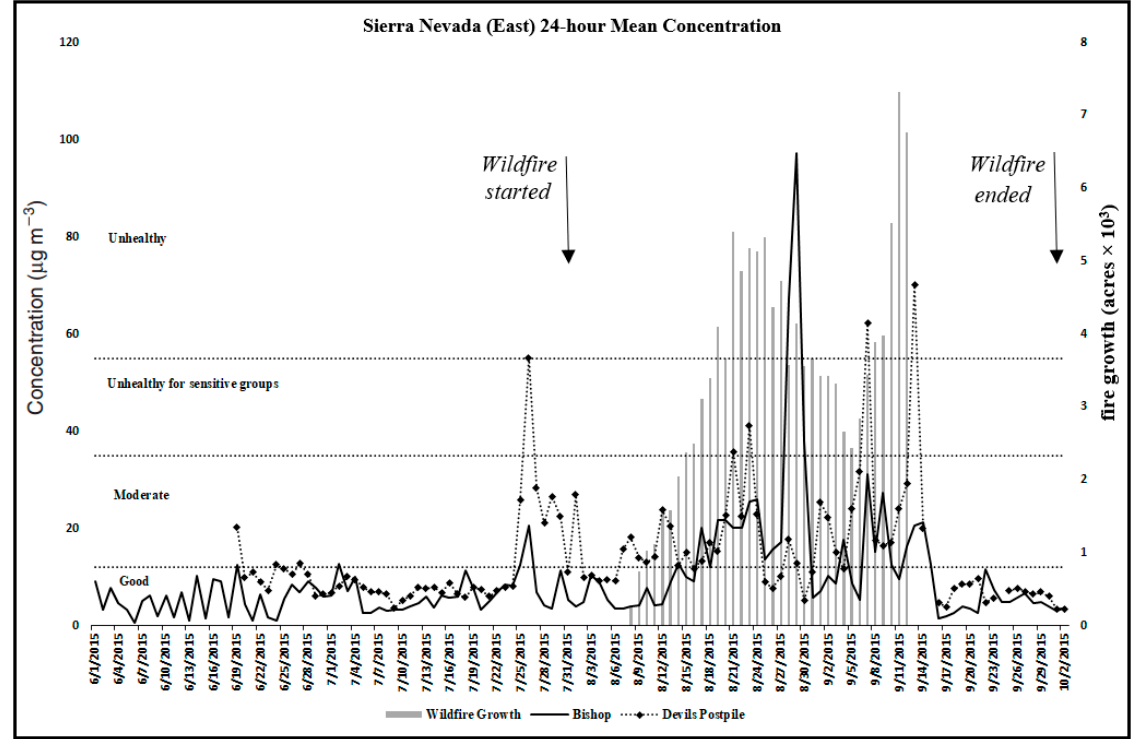
Figure 7. 24-Hour PM 2.5 concentrations with Air Quality Index (AQI) breakpoints for monitoring sites. Note: no daily fire growth data were available at the beginning of the fire.